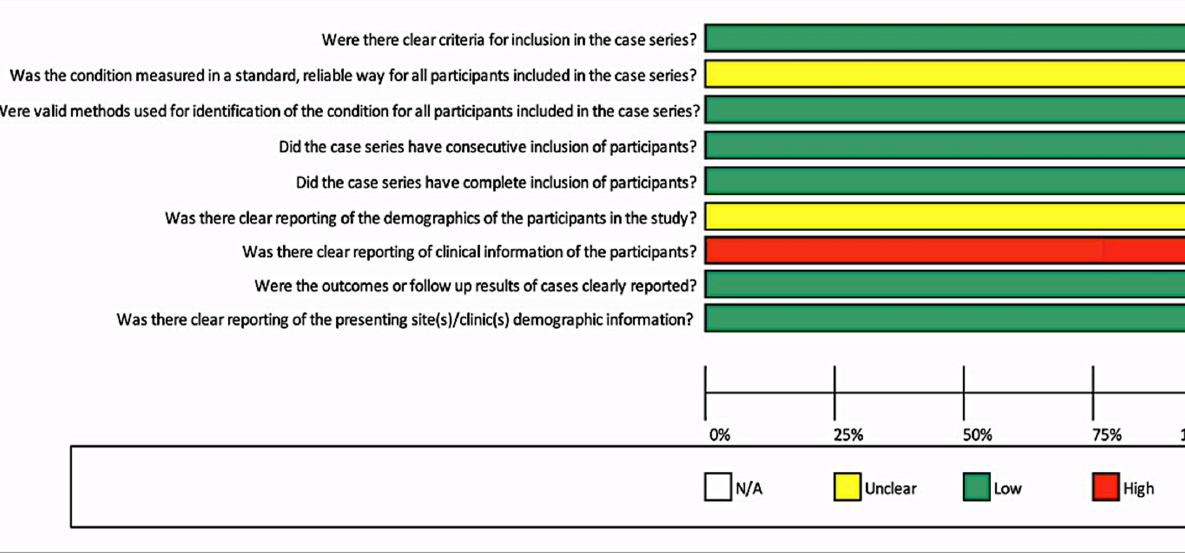
Figure 3. Risk of bias for case series.